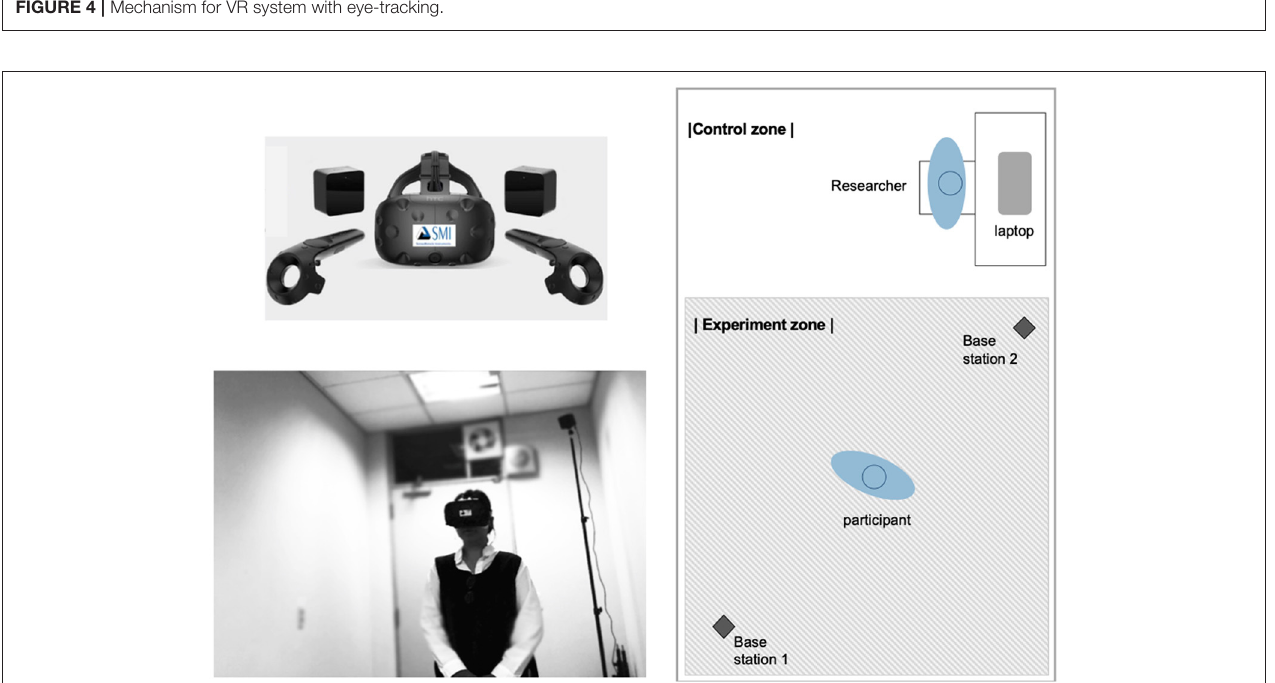
FIGURE 5 | Materials and experiment